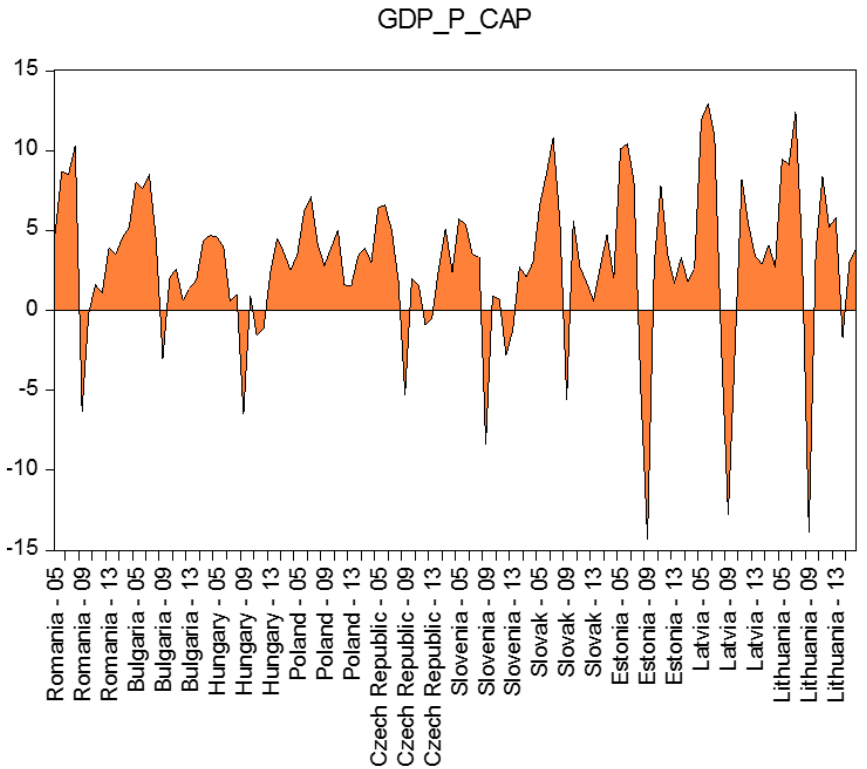
Figure 2. GDP per capita (GDP_P_CAP) annual percentage change in CEE countries.